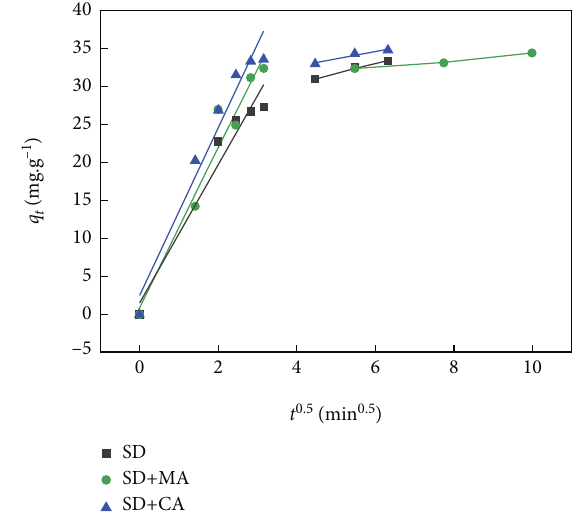
Figure 13: Multisegment fi tting curve of the intraparticle di ff usion model of adsorption of boron chloride on SD, SD+ MA, and SD +CA.